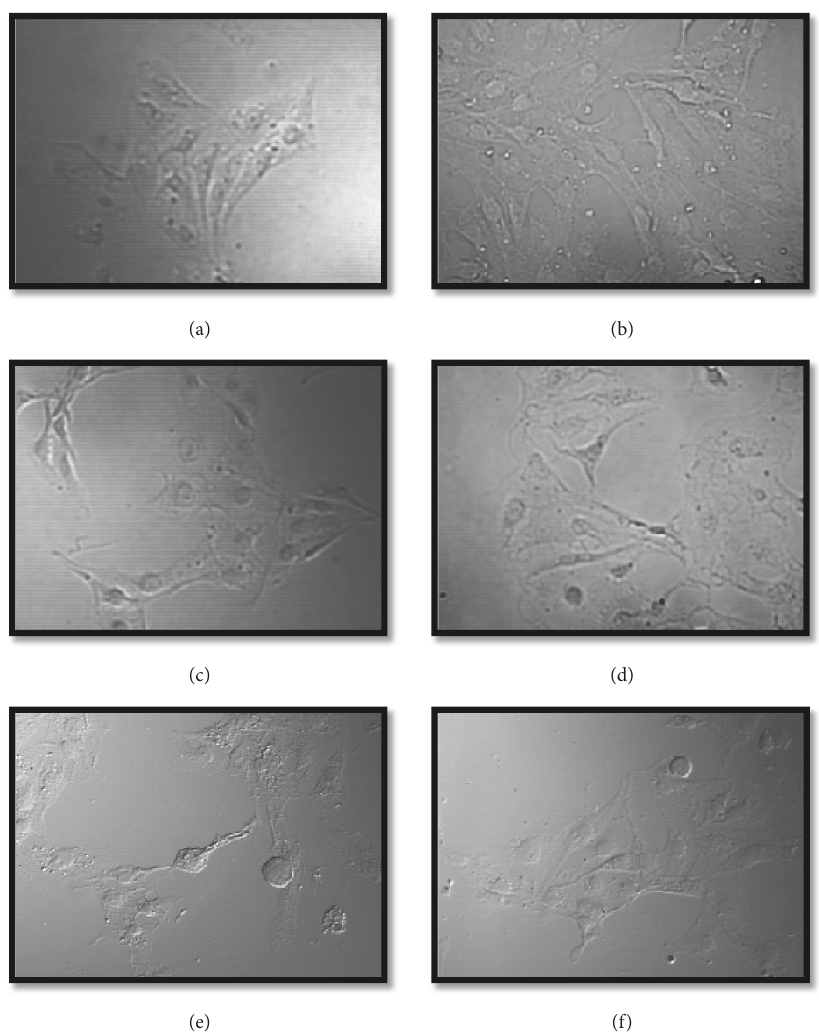
Figure 1: Morphological observation of LX-2 cells after treatment with (a) vehicle only, (b) acetaldehyde 100 𝜇 M, (c) acetaldehyde 100 𝜇 M + sorafenib 10 𝜇 M, (d) acetaldehyde 100 𝜇 M + alpha mangostin 10 𝜇 M, (e) acetaldehyde 100 𝜇 M acetaldehyde + alpha mangostin 20 𝜇 M, and (f) acetaldehyde 100 𝜇 M + alpha mangostin 10 𝜇 M. Observation was done under confocal microscope (20 x